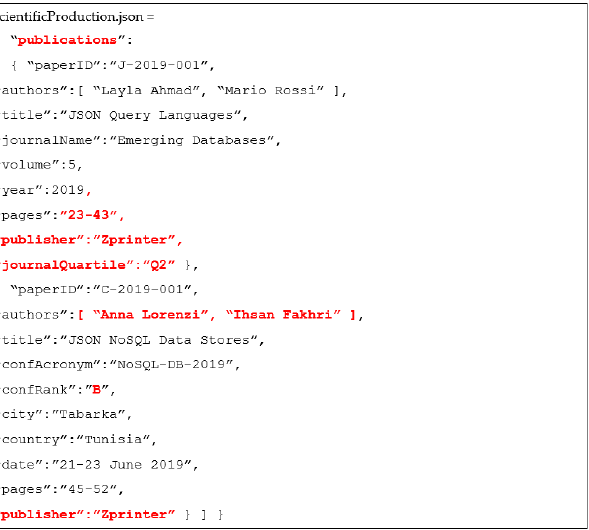
Figure 3. Final state of the “ scientificProduction.json ” JSON instance document after the execution of the sequence of JUpdate operations described in the text.